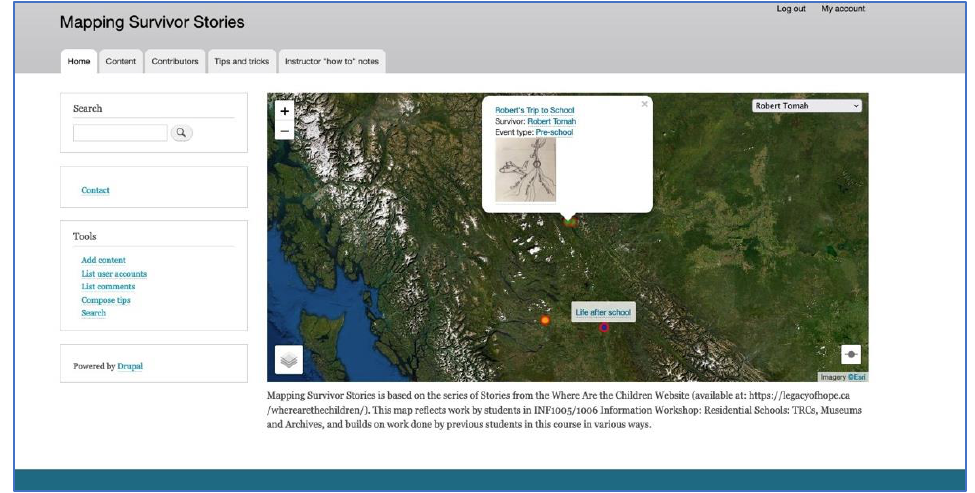
Figure 9. Screenshot of the Mapping Survivor Stories Map home page showing a thumbnail pop- up for Robert’s memory of flying from home to begin attendance at Lejac Residential School.